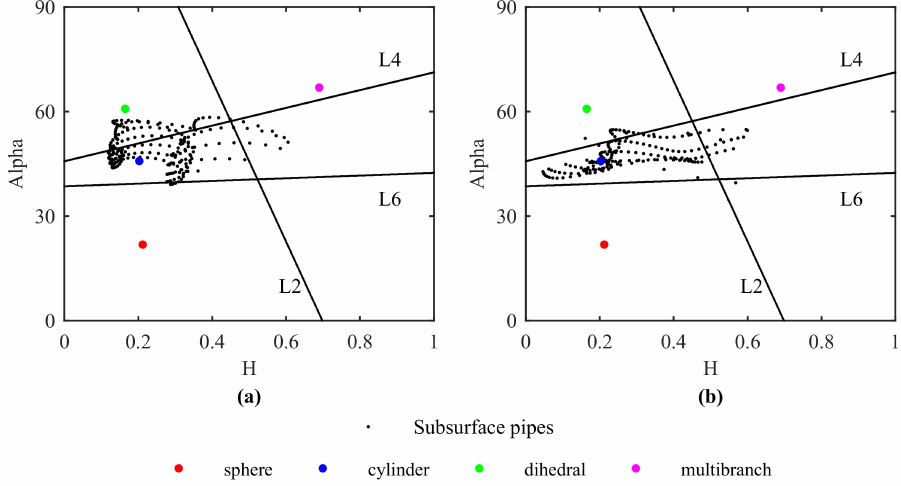
Figure 19. Particle center supported plane result. ( a ) Pipe 1. ( b ) Pipe 2. Table 3. Classification probability of subsurface pipes.